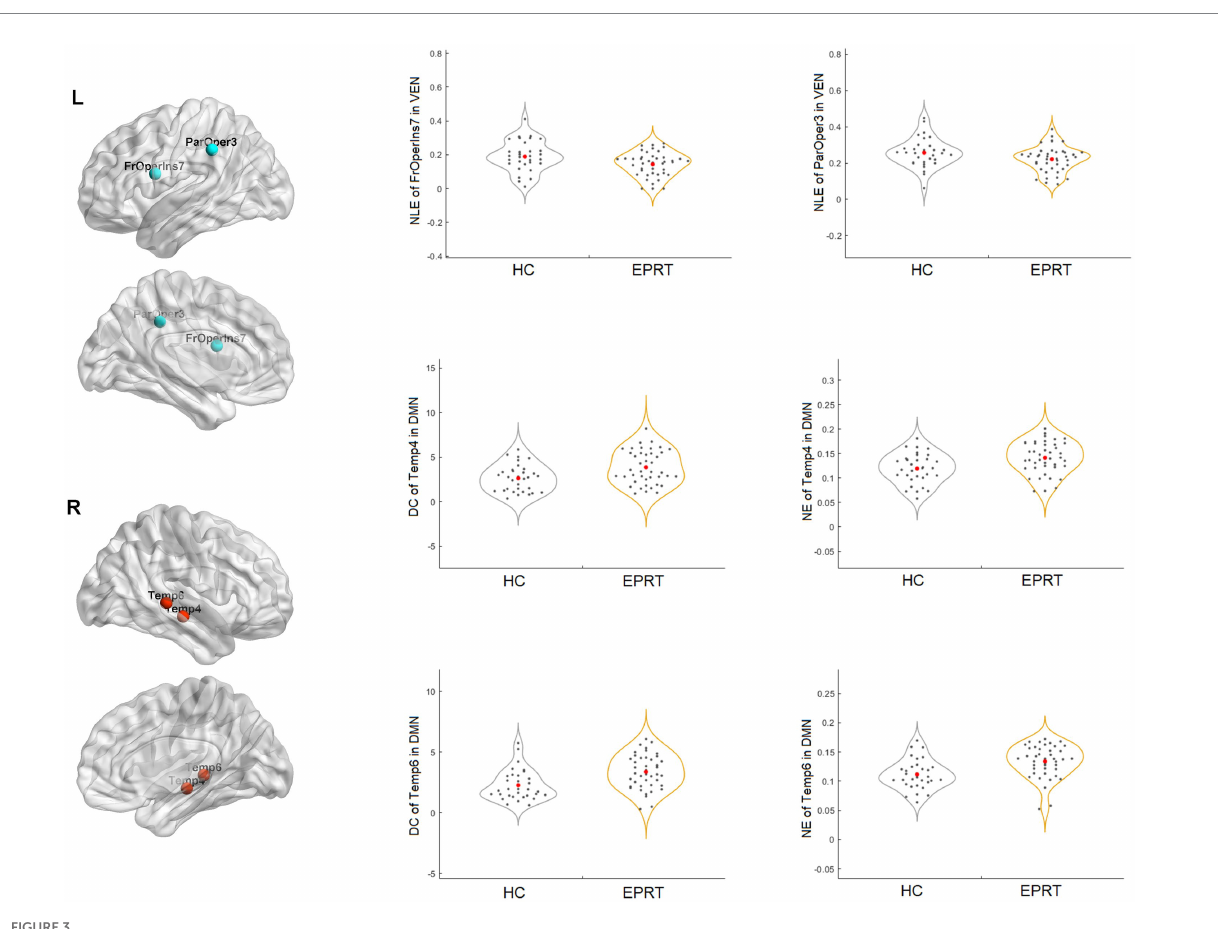
FIGURE 3 Brain regions with significant differences between EPRT and HC at